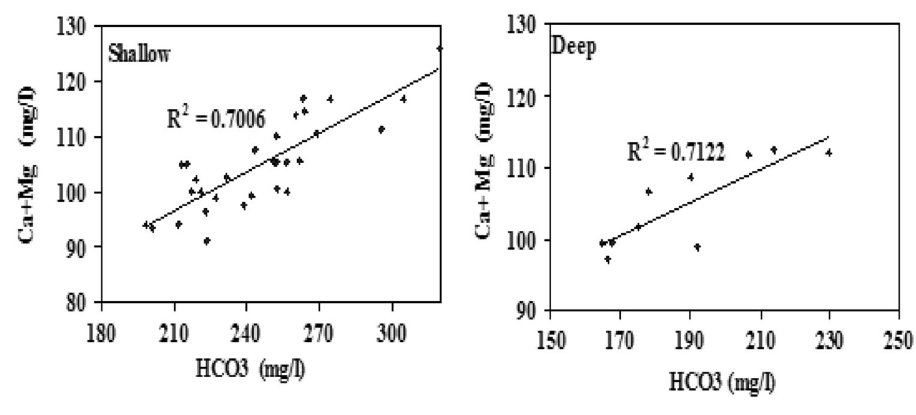
Fig. 5 Ca ? Mg versus HCO 3 - indicate these ions are generally derived from the dissolution of carbonate minerals